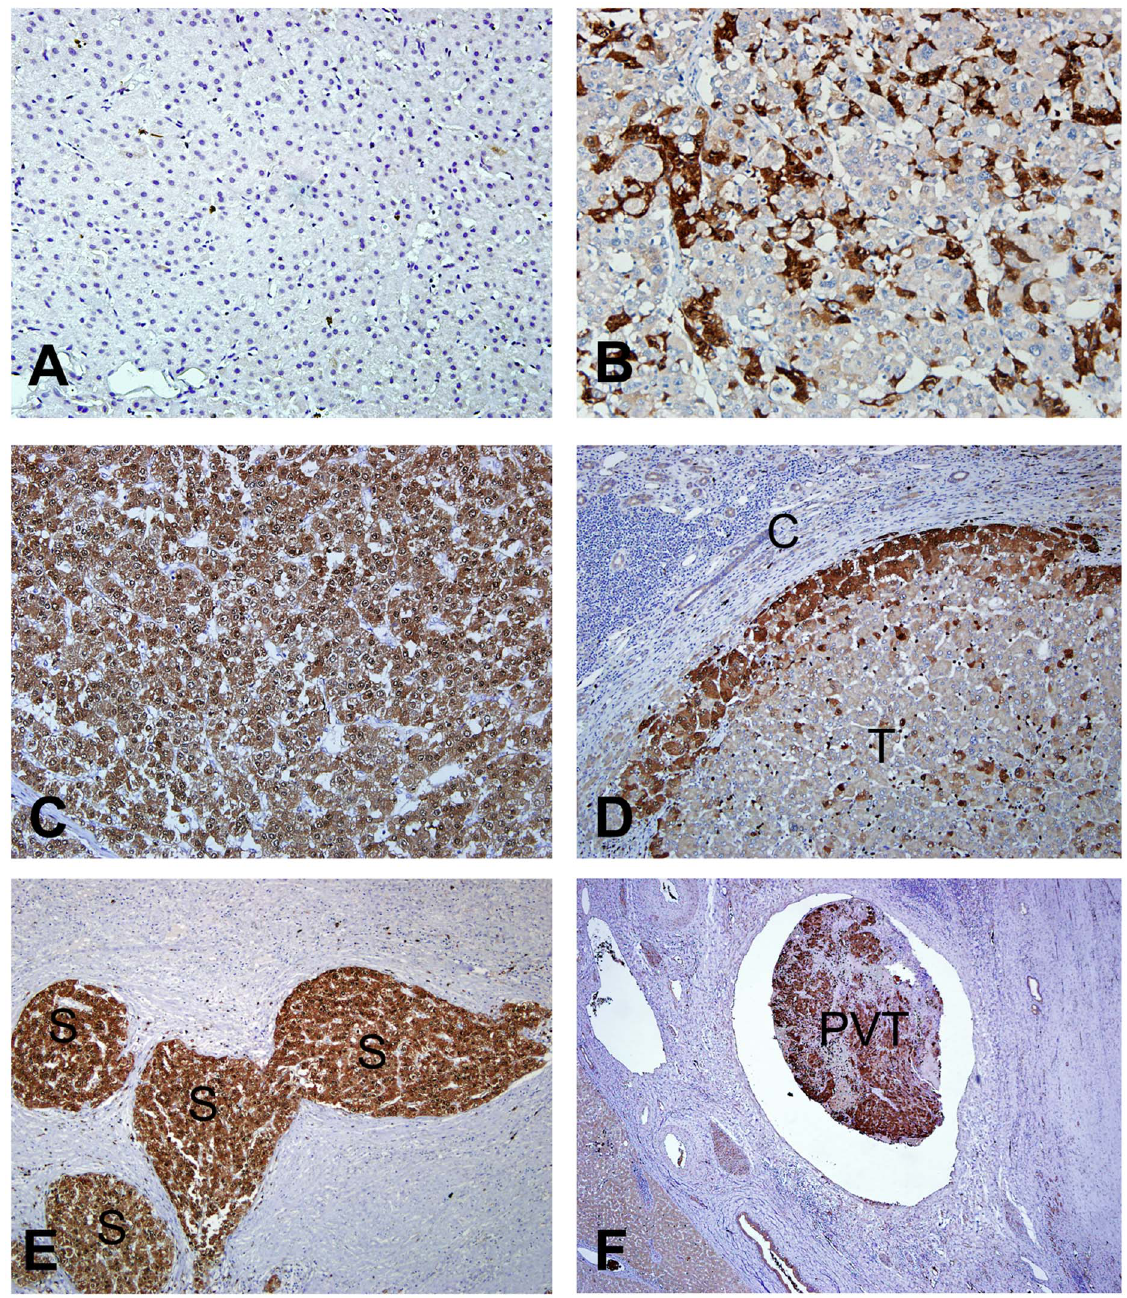
Figure 2. Expression of S100P in HCC and non-cancerous liver parenchyma. (A) No immunostaining of S100P in non-cancerous liver parenchyma. (B and C) Heterogeneous and diffuse expression of S100P in HCC. (D) The expression of S100P was more prominent at the periphery of the tumor mass near the tumor capsule. (E) Strong expression of S100P in satellite nodules. (F) A portal vein tumor embolus exhibiting strong S100P expression. T: tumor, C: capsule, S: satellite nodule, PVT: portal vein tumor embolus.